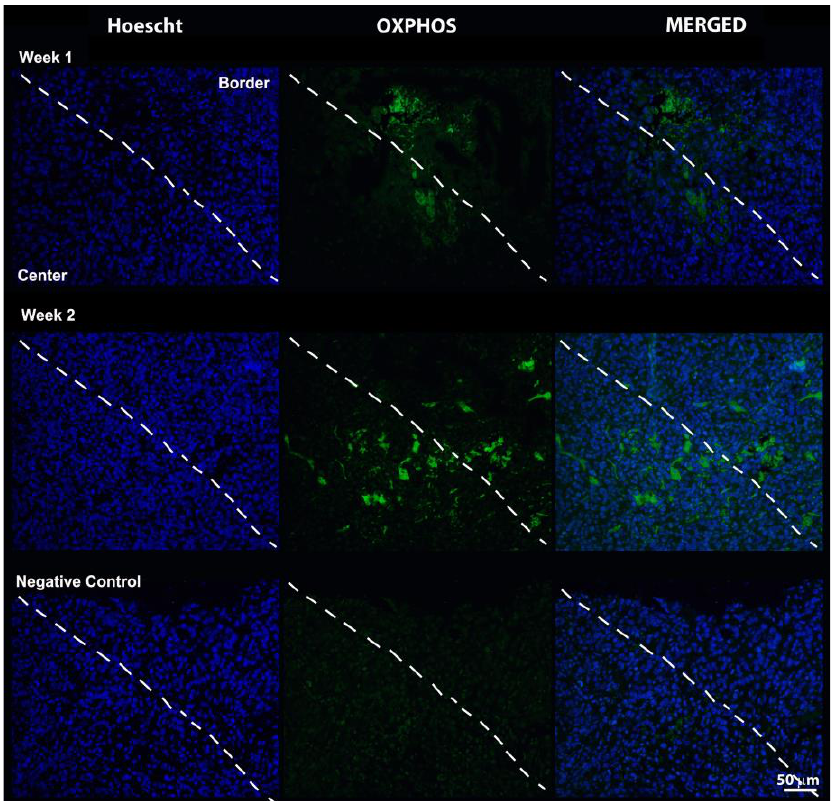
fusion of all three. The dashed line divides the tissue section, where the upper region corresponds to the tumor edge and the lower region corresponds to the tumor center.